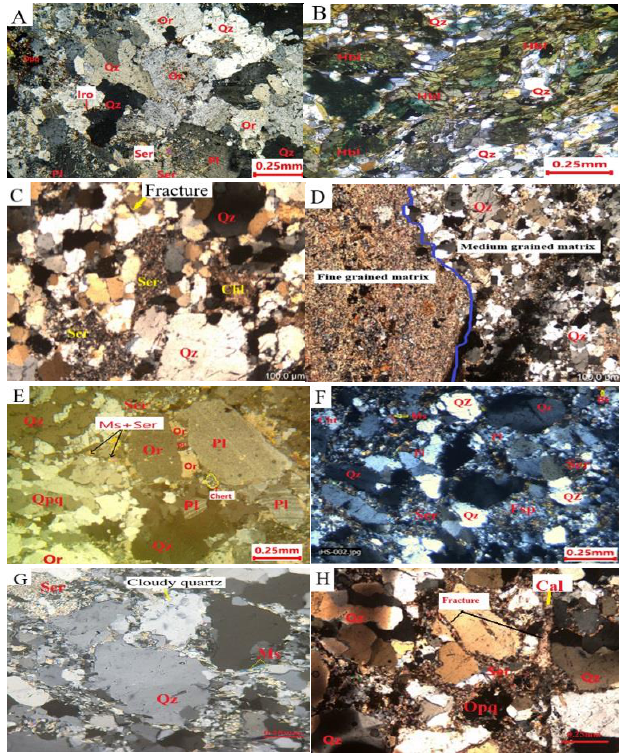
Figure 2: Photomicrographs of the conglomerates and sandstones: (A) Interlocking texture of the slightly elongated syenogranite with moderately altered plagioclase (B) Matrix of the Chagupana conglomerate showing slight alignment of biotite (C) Greenstone pebble in the Kawere conglomerate (D) Matrix of the Kawere conglomerate showing variation in grain sizes (E) Chagupana sandstone showing well to moderately preserved plagioclase and fine-grained chert (F) Huni sandstone showing rapid alteration of feldspar (G) Quartz in Banket sandstones showing sutured edges. (H) Deformed Kawere sandstone with microfractures and calcite as infill materials. Qz = quartz, Ser = sericite, Ms = muscovite, Pl = plagioclase, Bt = biotite, Or = orthoclase, Opq = opaque mineral, Cht = Chert, Hbl = hornblende, Cal=calcite (Whitney and Evans, 2010). Kawere conglomerate The Kawere conglomerate was sampled from the Bonsa area of the Western region of Ghana. The samples are well indurated, greenish-grey and composed predominately of closely packed, angular to rounded clasts